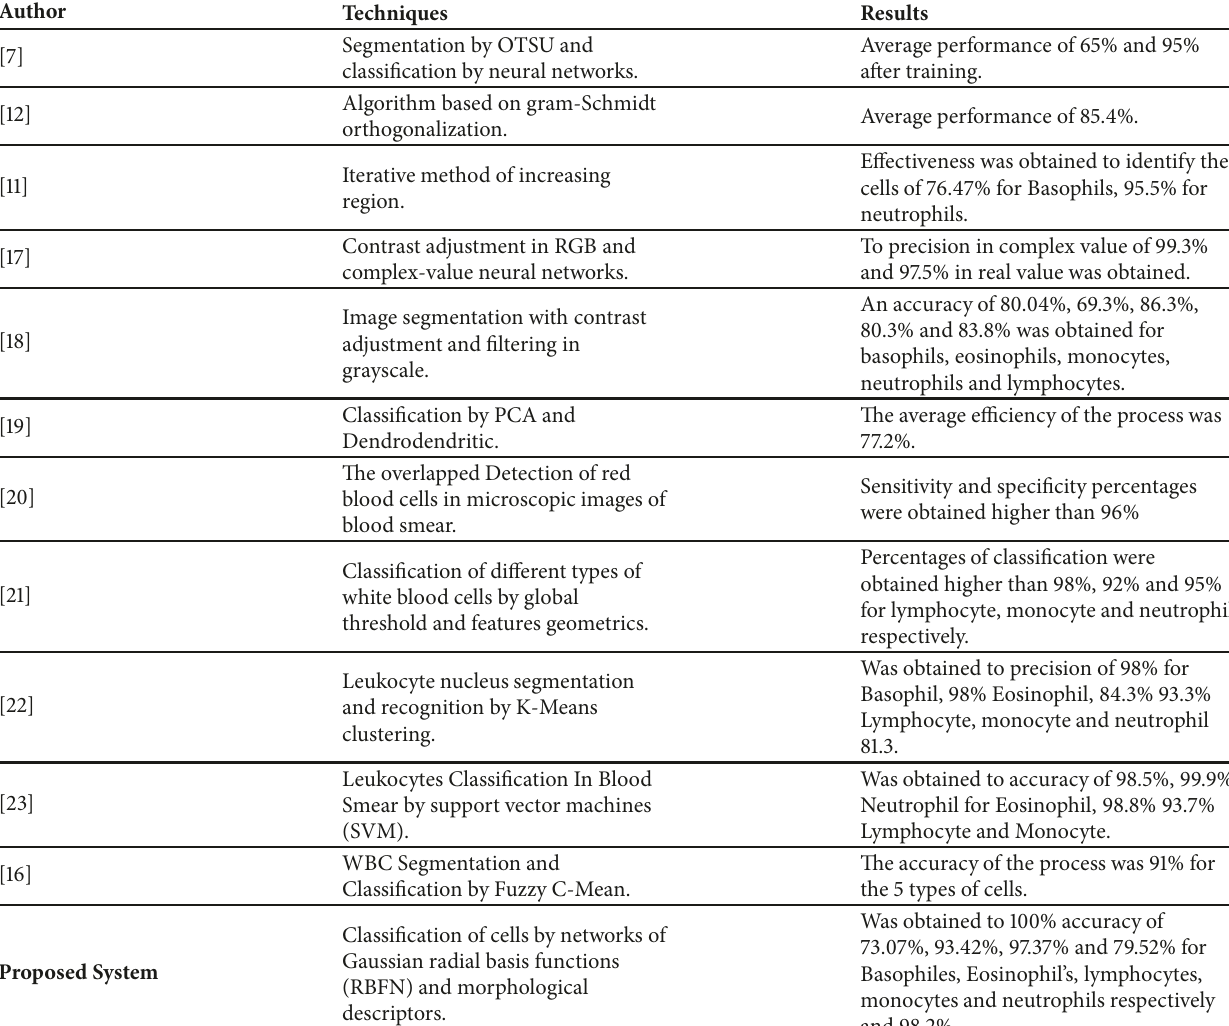
Table 4: Comparison between systems semiautomatic versus developed